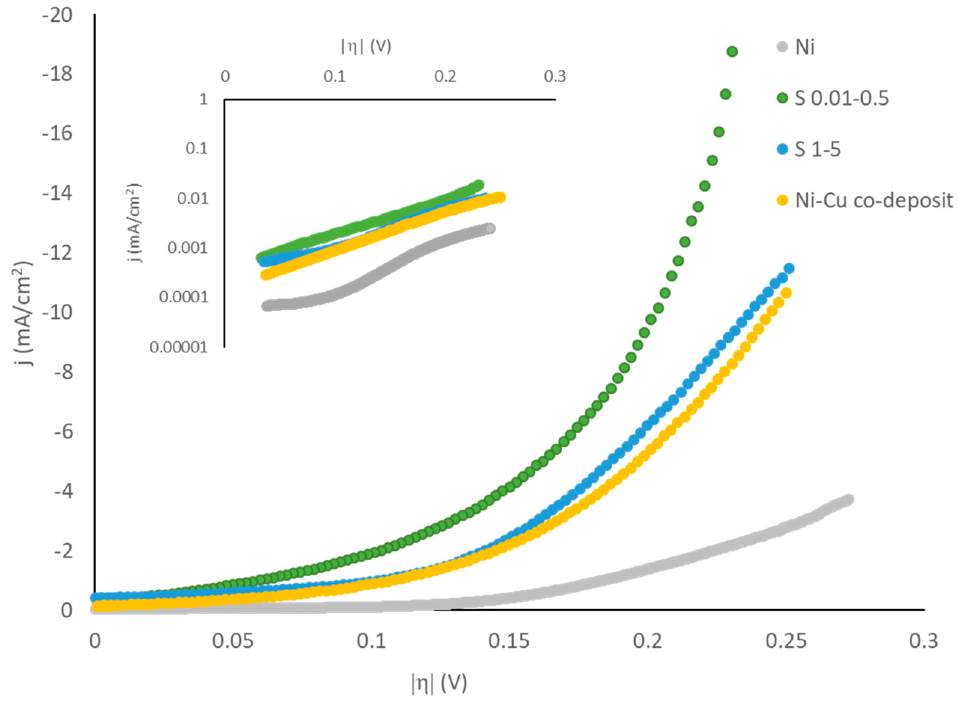
Figure 6. Linear sweep voltammetries in 1 M KOH solution; inset: magnification of the linear Tafel polarization curves.